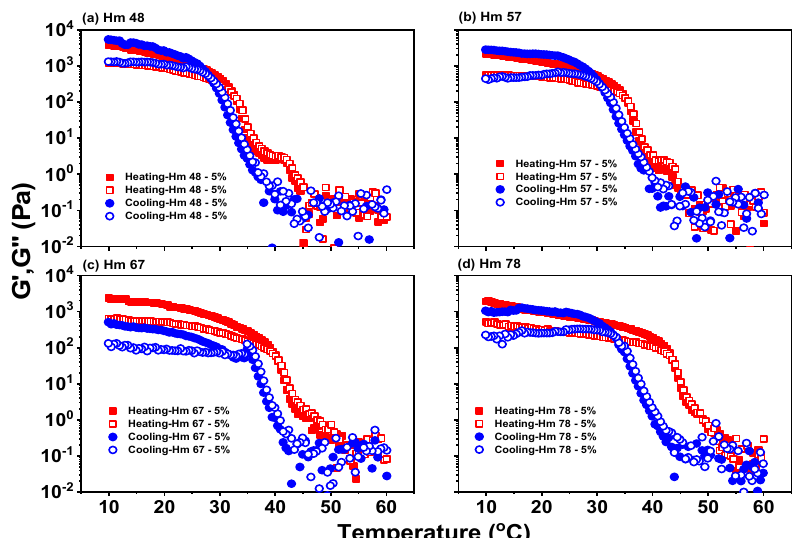
Figure 2. Variations in storage ( G’ , filled symbol) and loss ( G” , open symbol) moduli of 5% ( a ) Hm48, ( b ) Hm58, ( c ) Hm67, and ( d ) Hm78 solutions as a function of temperature at a frequency of ω = 10 rad/s and a strain amplitude of γ = 0.1%. Symbols ( ■ , □ ) and ( ● , ○ ) are for heating and cooling sweeps, respectively.